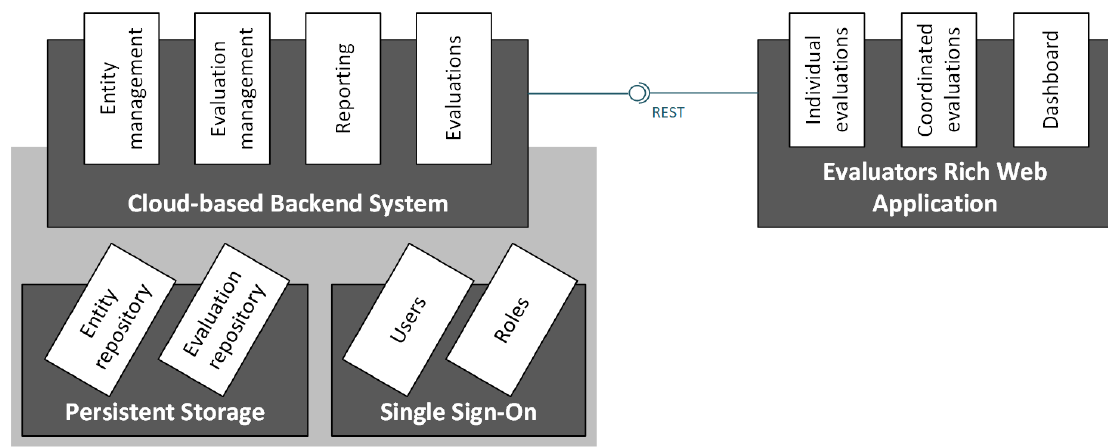
Figure 4. Source Code Quality Judgment Tool Architecture.